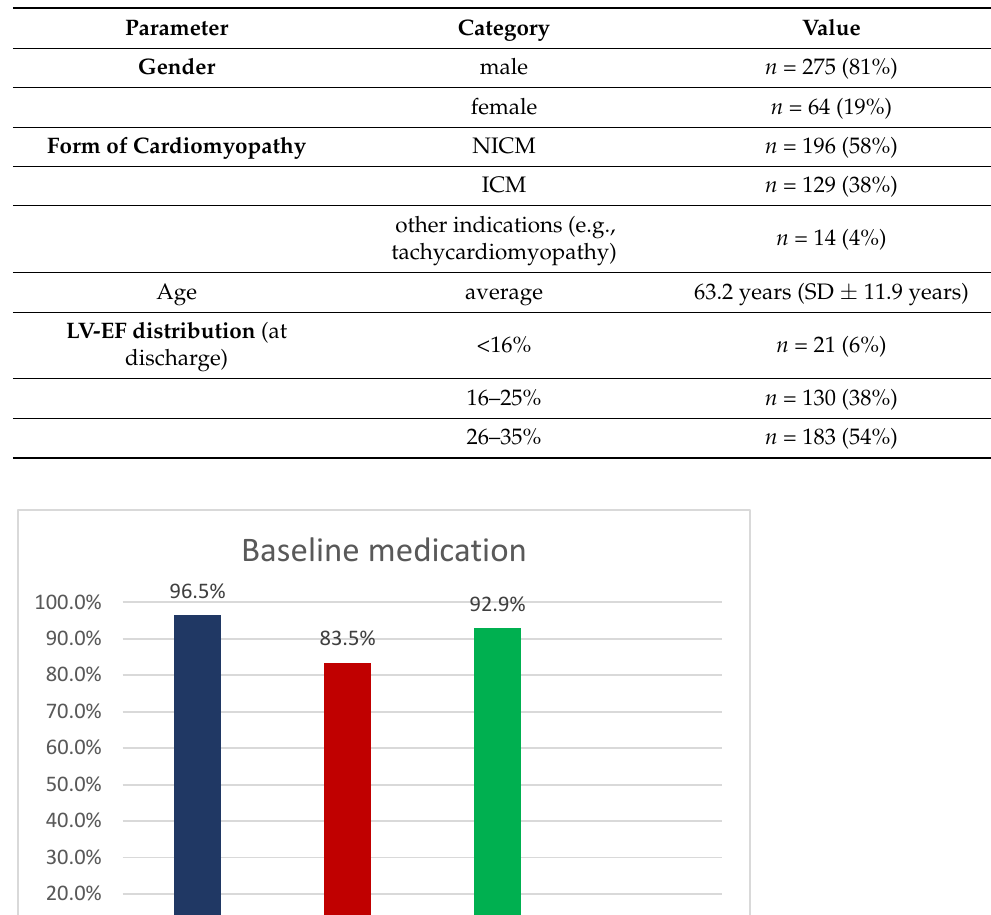
Table 2. Patient characteristics.